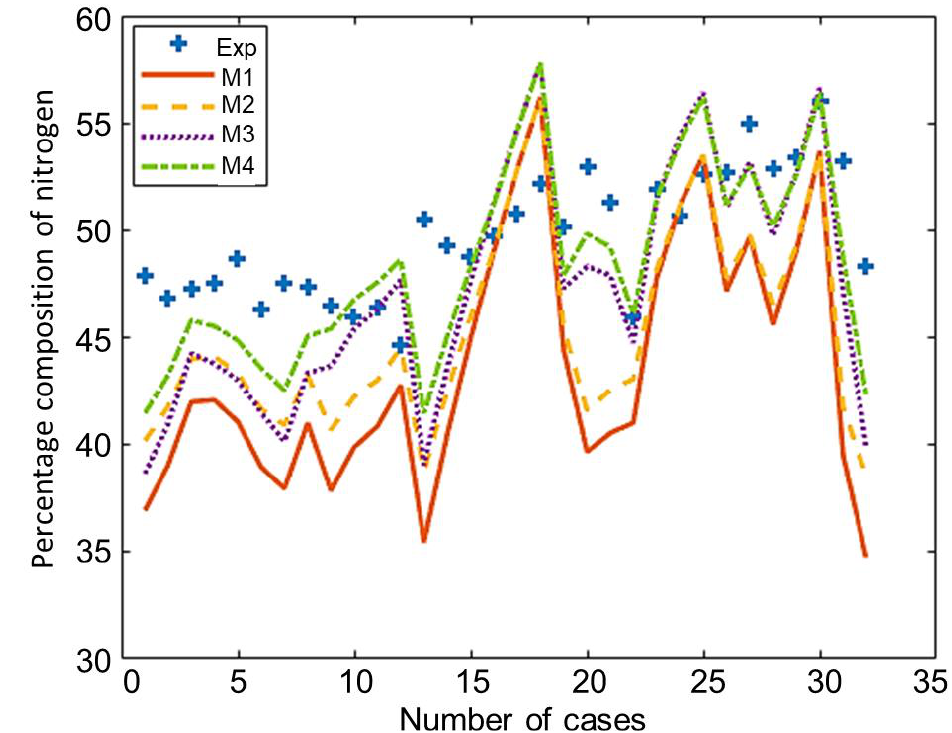
Figure 7. Comparison of nitrogen composition given by experiments and models.